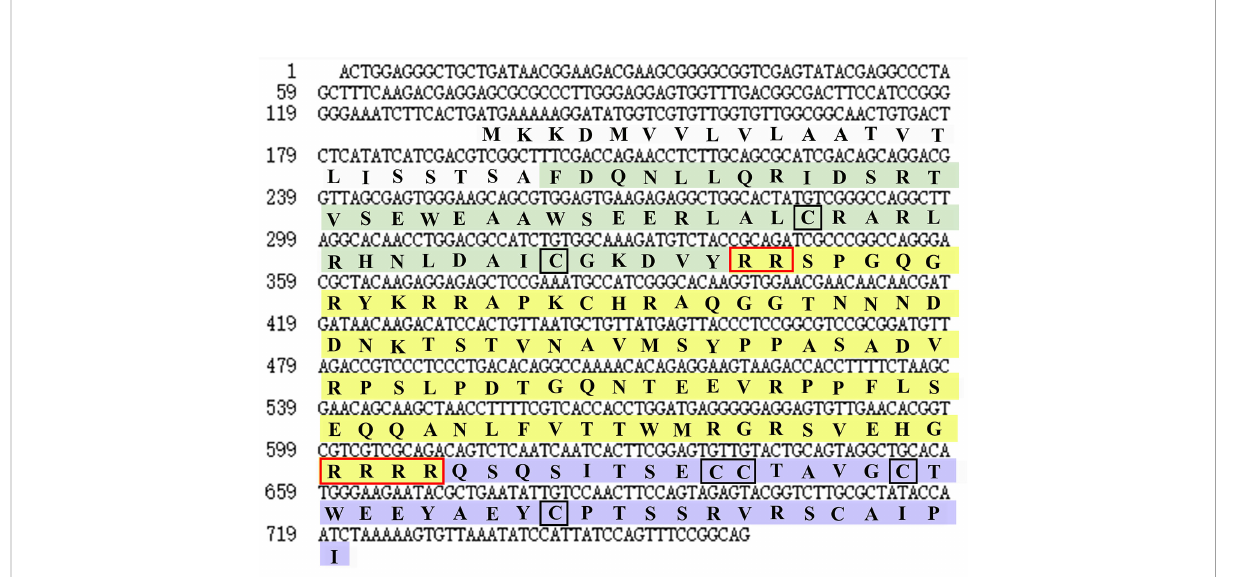
FIGURE 1 Nucleotide and deduced amino acid sequences of EcILP . Nucleotide and amino acid sequence of EcILP are shown in lowercase and uppercase, respectively. The sequence of B, C and A chains are stained in green, yellow and purple, respectively. Two cleavage sites and six cysteine residues are shown in red and black boxes,